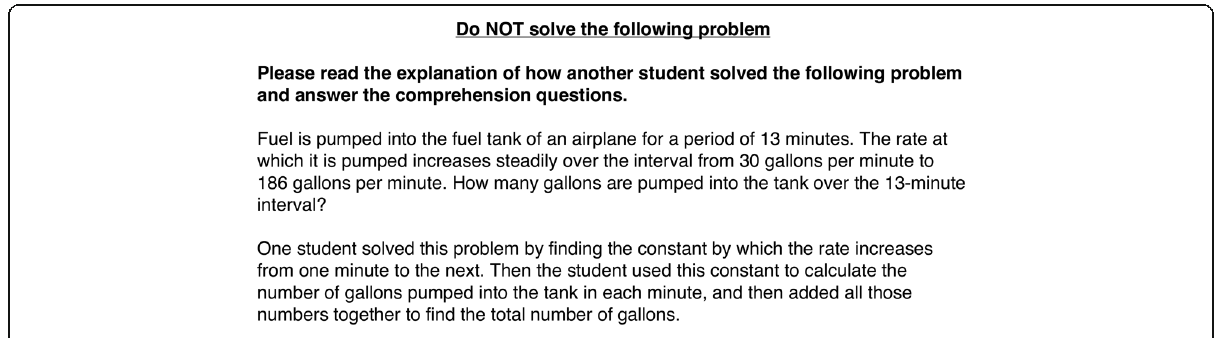
Fig. 2 Description of the summation strategy from the exposure section of the packet